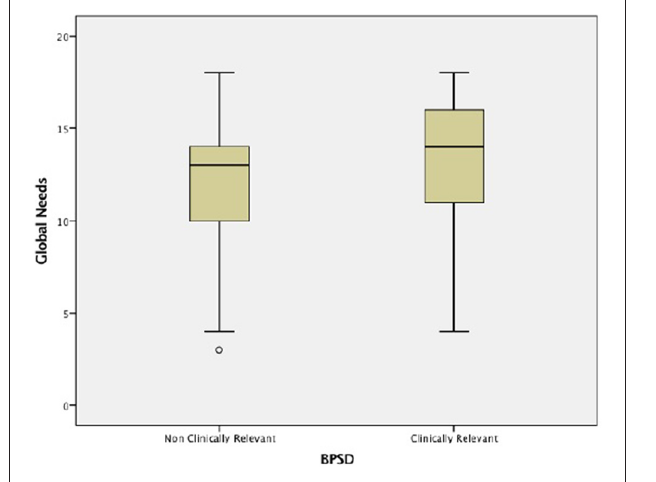
FIGURE 3 | Global needs considering behavioral and psychological symptoms .